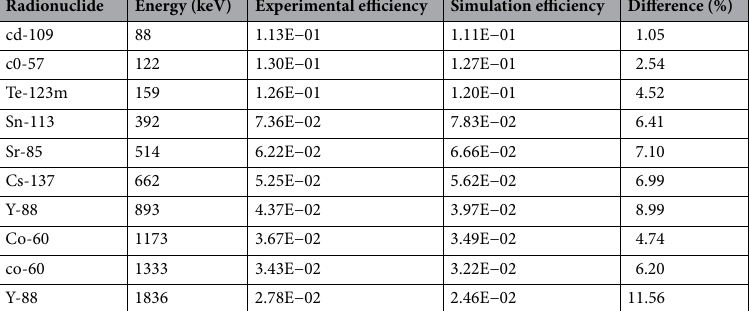
Table 1. Experimental efficiency vs. simulation efficiency of the 100% efficient HPGe detector measured with a multi-nuclei liquid source at 0 cm.